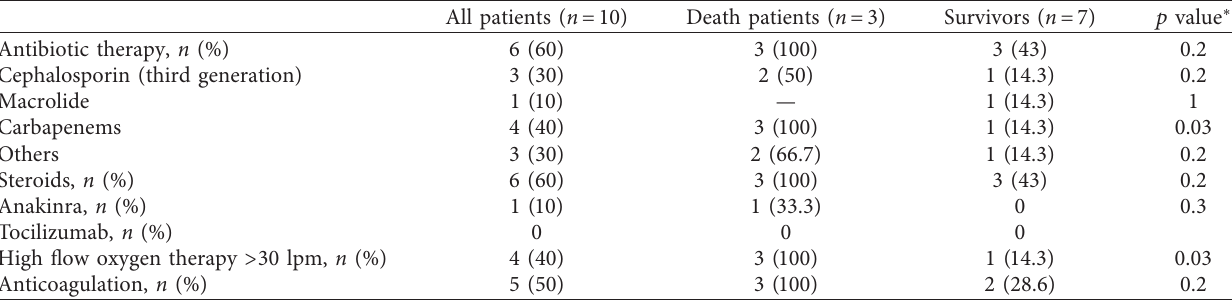
Table 2: Patients’ treatment and outcome.